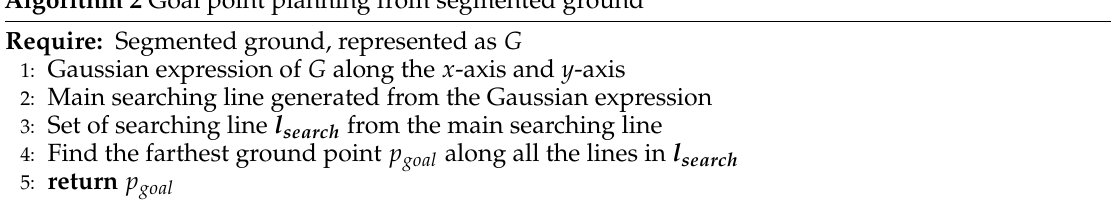
Algorithm 2 Goal point planning from segmented ground